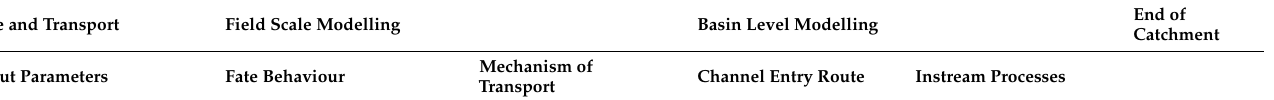
Table 4. Parameters impacting the fate and transport of herbicides into the